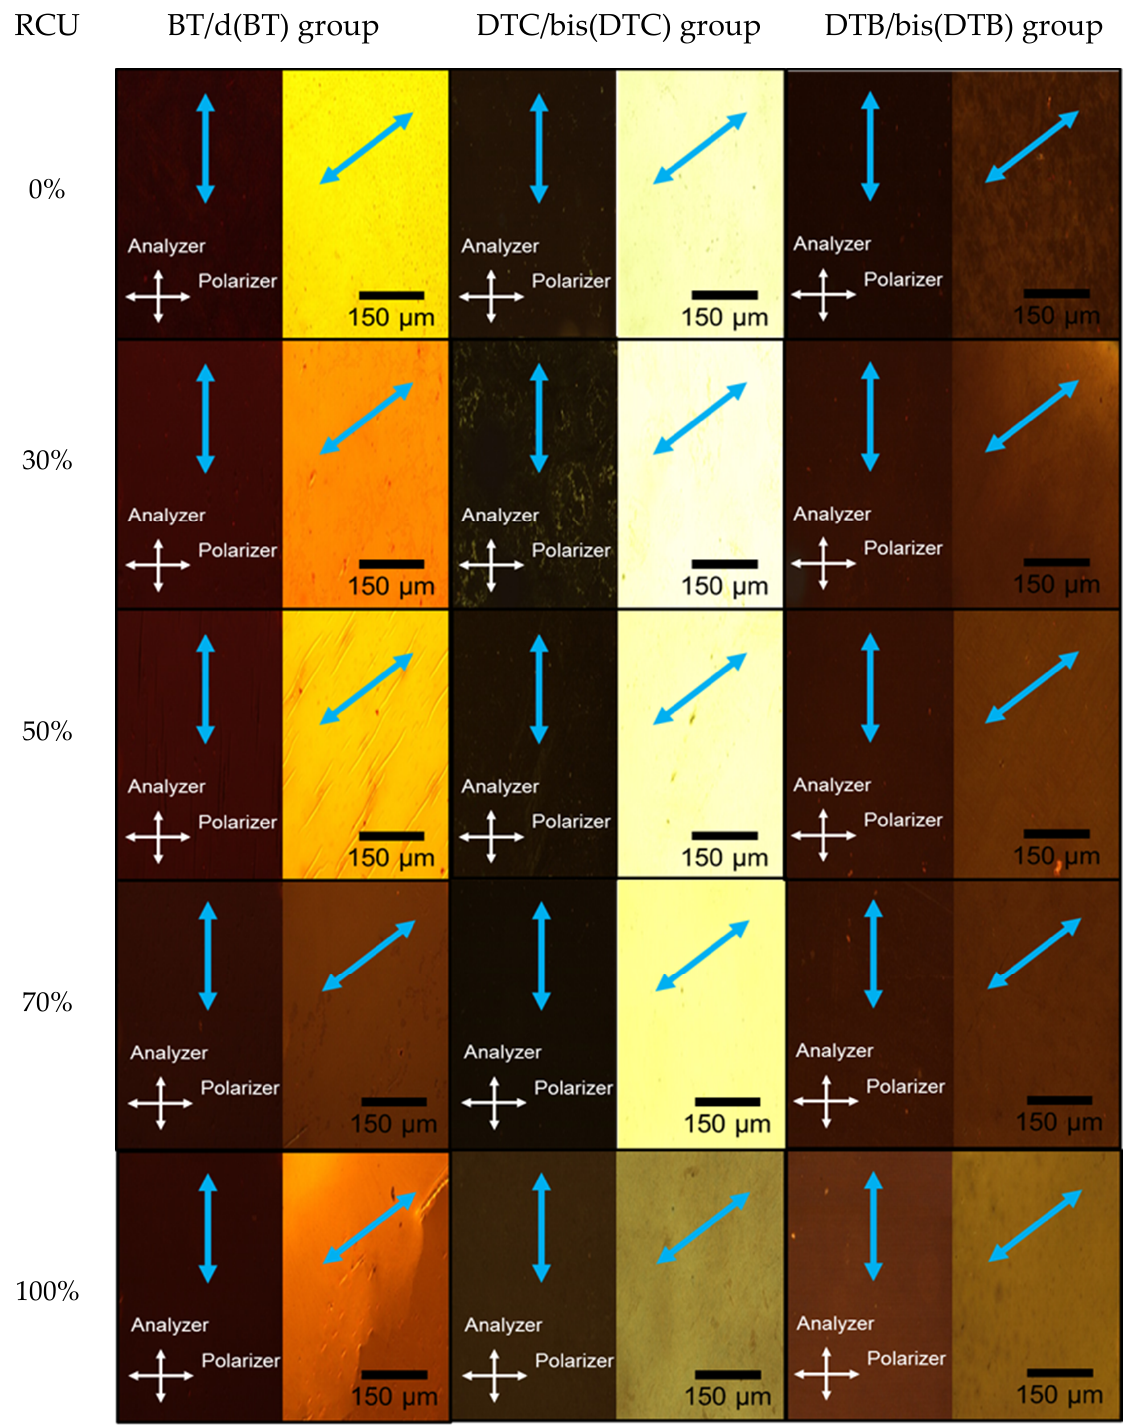
Figure 3. POM images of polymer films obtained from the BT/d(BT) group, DTC/bis(DTC) group, and DTB/bis(DTB) group with different RCUs. For comparison, a photograph was first taken of a sample ( left side ), and then the sample was rotated 45° and a second photograph was taken ( right side ). Blue arrows indicate the orientation direction. RCU: Ratio of crosslinked units.